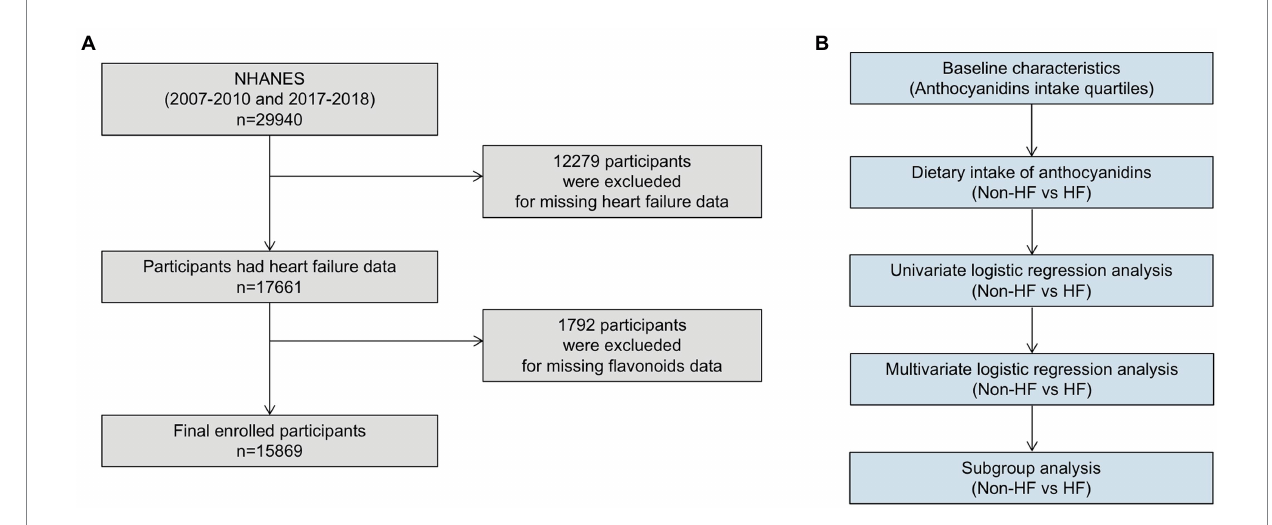
FIGURE 1 (A) Flow chart of participants selection; (B) flow chart of data